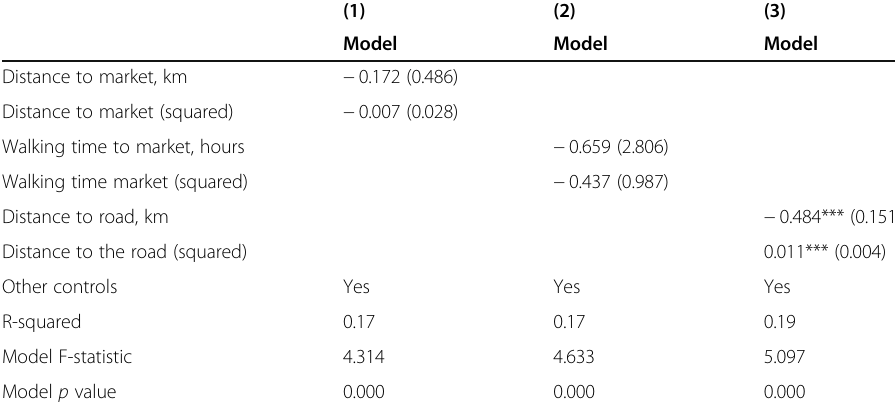
Table 9 Association between Market Access and Food Consumption Score (FCS) for 324 smallholder